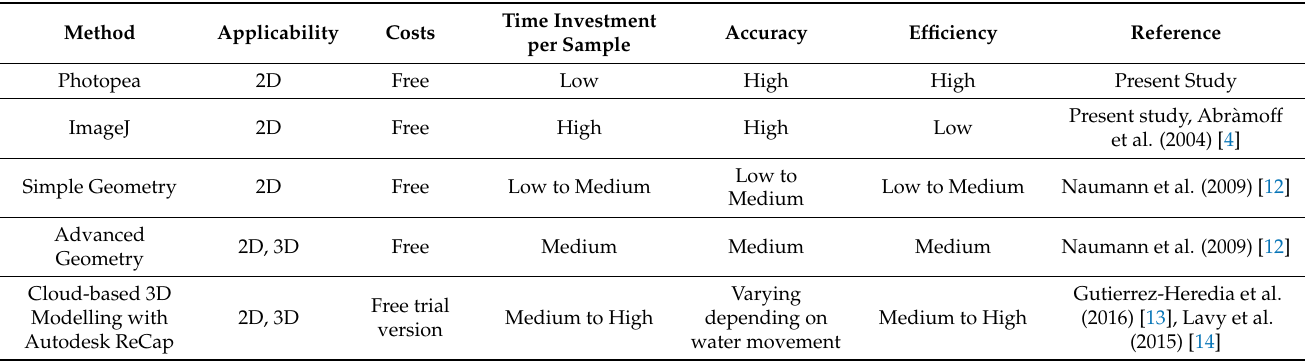
Table 2. Comparative overview regarding the costs, time investment, accuracy and efficiency of various approaches to determine surface areas of two- and three-dimensional biological